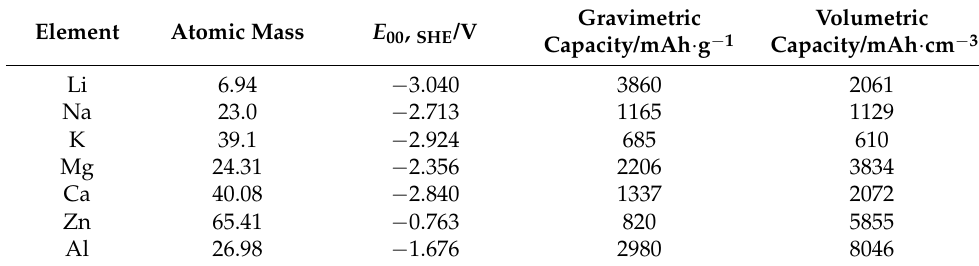
Table 1. Some characteristic data of potential candidate materials for metal-ion batteries [2].